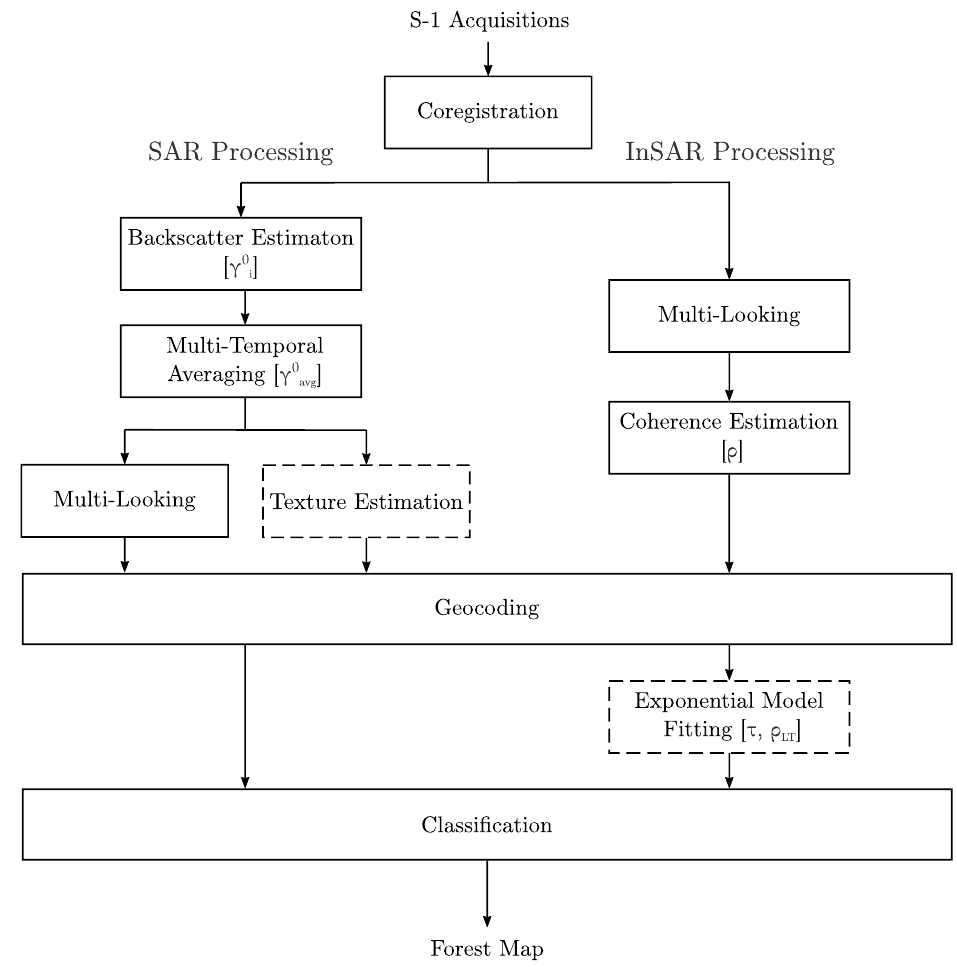
Figure 2. Short time series processing chain as developed in [24]. Our goal was to reduce the processing time required for classifying S-1 InSAR images by skipping the texture estimation and exponential model fitting steps (highlighted using dashed lines). To this end, we propose a CNN for automatically learning relevant